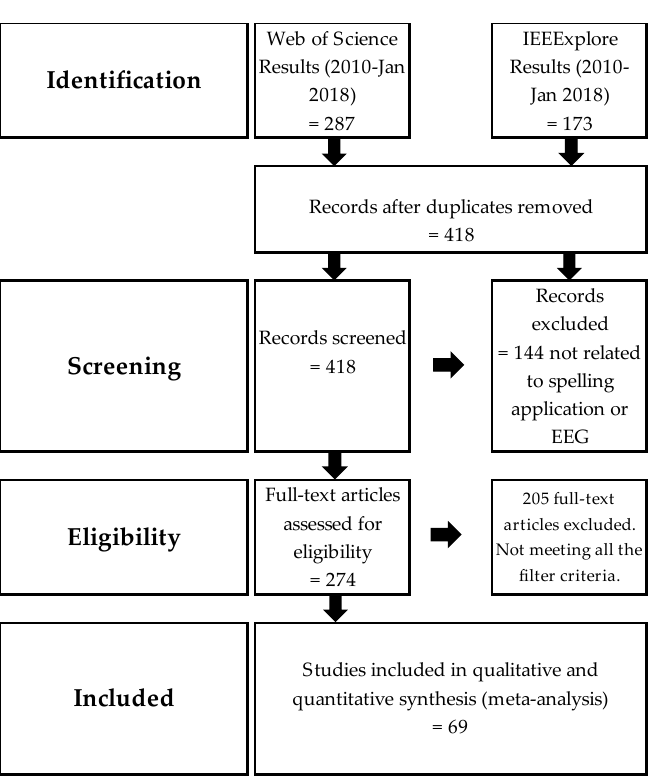
Figure 2. PRISMA